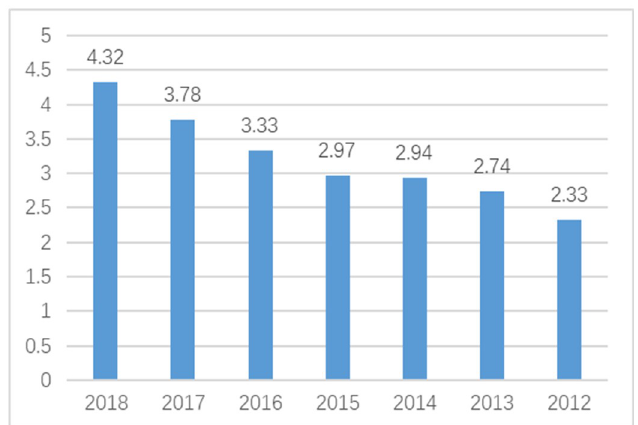
Fig 5. China’s online literature user scale in 2012–2018 Unit: 100 million people. Source: CNNIC, China Industrial Research Institute.